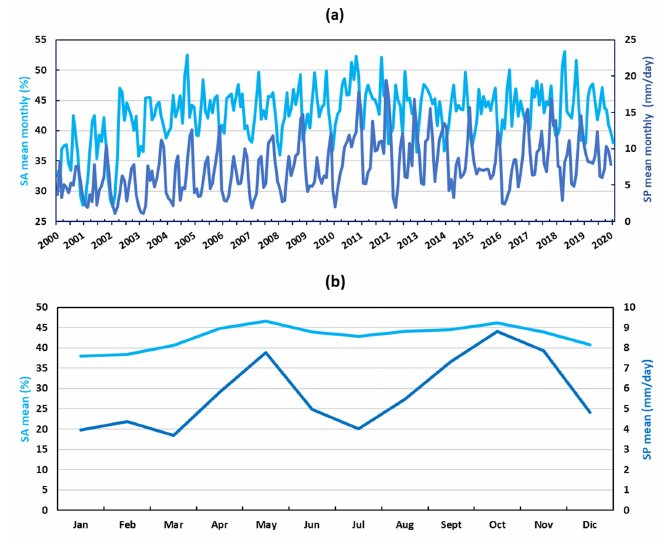
Figure 3. Panel ( a ) show the monthly variation of SA and SP. While panel ( b ) displays the and intra-annual variations of SA mean monthly and SP mean monthly for the period 2000 to 2020 in the SNSM. (For interpretation of the references to color in this figure legend, the reader is referred to the web version of this article.). Error! Reference source not found. b,c showed that the values of BC and OC show that the higher values were related to reductions in SA. However, no significant negative relationships of BC and OC were observed in SA. Error! Reference source not found. d shows the monthly behavior of snow albedo and dust surface mass concentration. It is shown that high snow albedo values were associated with low concentrations of surface dust. While the combined effect of BC, OC, and dust seems to have a significant effect in reducing the SA of the SNSM ( Error! Reference source not found. e). Thus, considering the rain cycles observed in Error! Reference source not found. b, and the